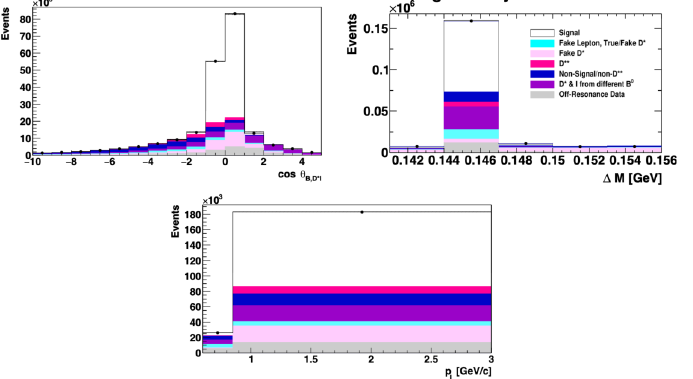
Figure 1. Fits to the cos θ B (top-left), ∆ M (top-right), and p ` (bottom) in the µ mode. The points represent the